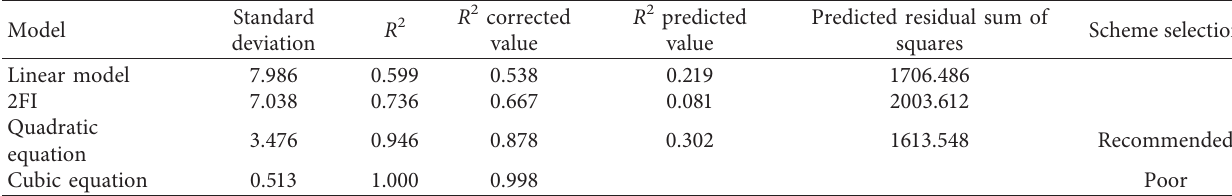
Table 11: Comprehensive evaluation of R 2 of combustibility index.